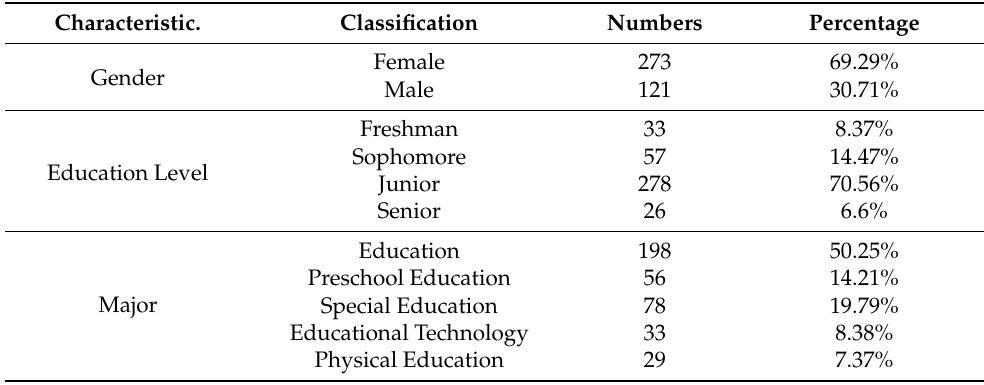
Table 1. Sample distribution (total = 394).